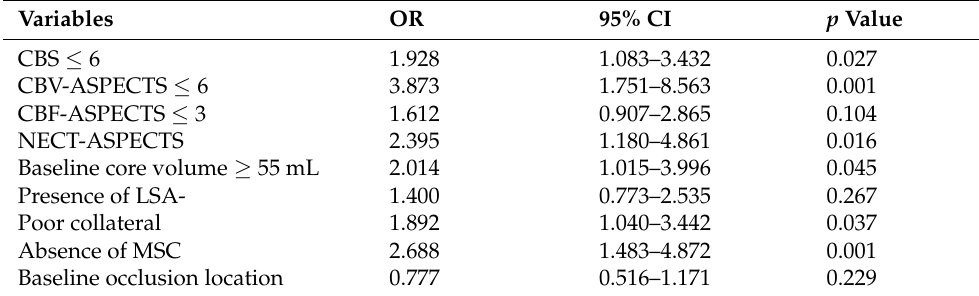
Table 2. Logistic regression analysis for poor